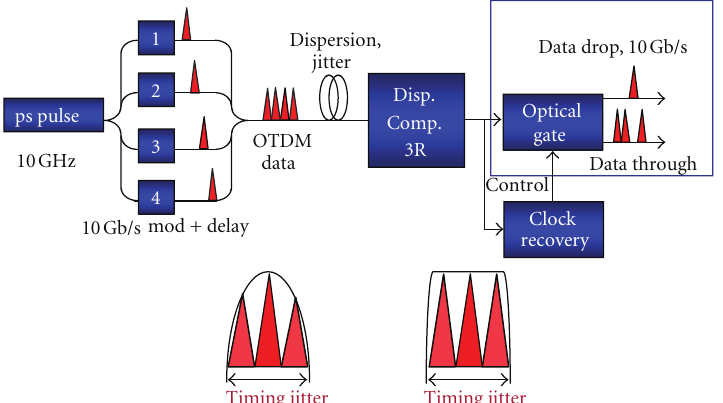
Figure 1: General schematic of demultiplexing in OTDM by nonlinear switching and illustration of the timing-jitter tolerance improvement achieved by use of flat-top pulse